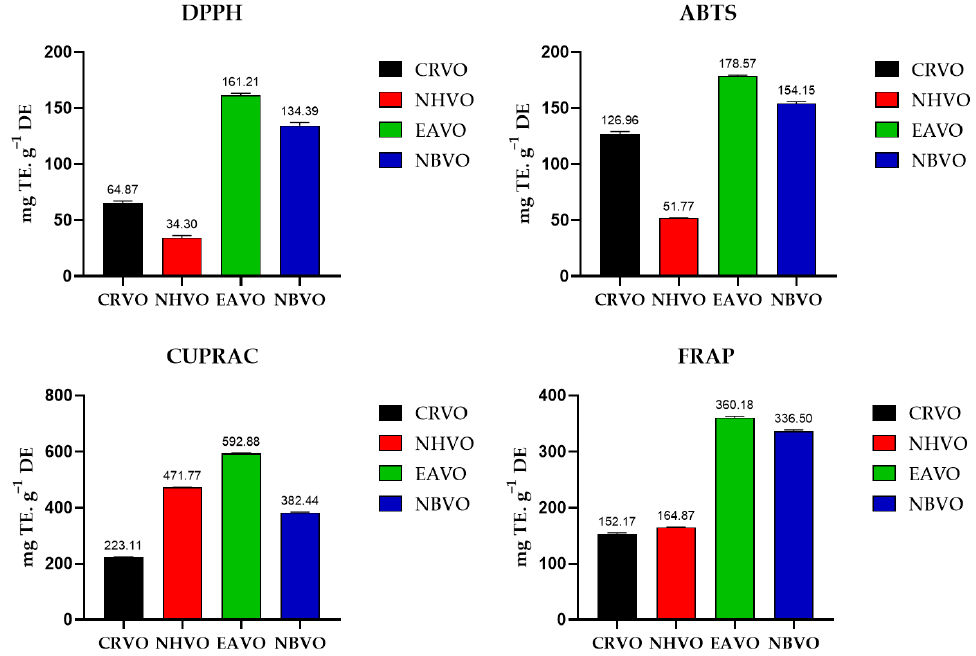
Figure 3. Antioxidant activity of crude methanolic extract (CRVO) and different fractions ( n -hexane extract (NHVO), ethyl acetate extract (EAVO), and n -butanol extract (NBVO)) of the whole plant of Verbena officinalis by DPPH ABTS, CUPRAC, and FRAP assays. (All experiments were performed in triplicates, and the error bar represents the standard